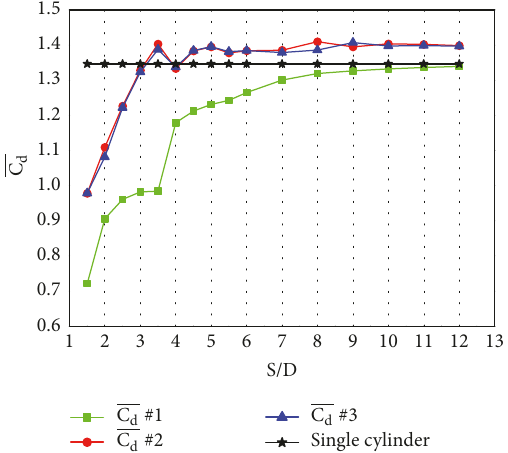
Figure 18: Temporal evolution curve of lift and drag coefficients for three cylinders at 𝑆/𝐷 = 4.0 .